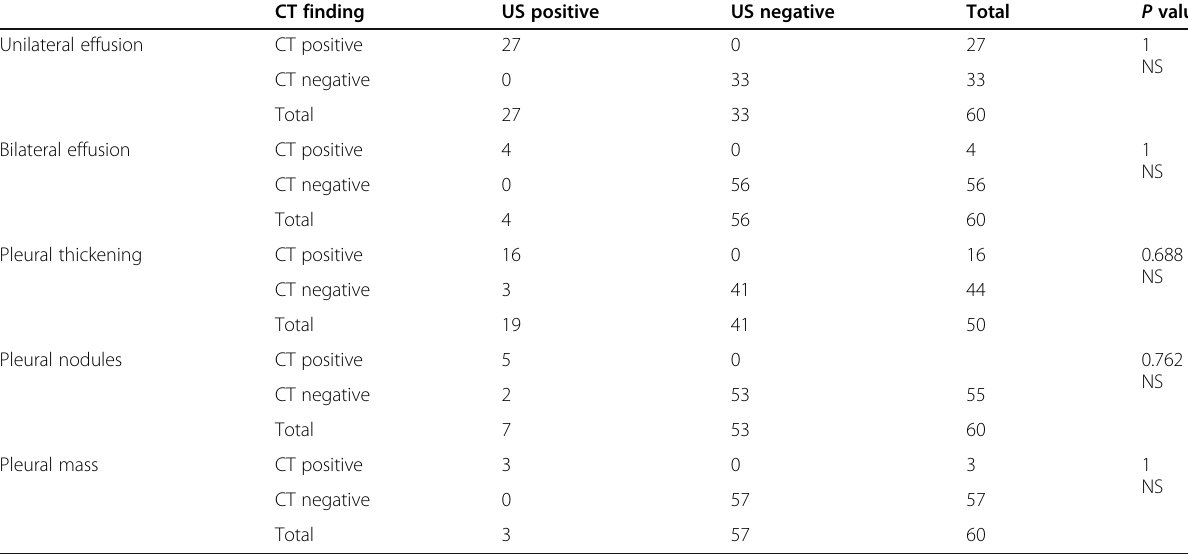
Table 7 Assessment of pleura by US in comparison to CT CT